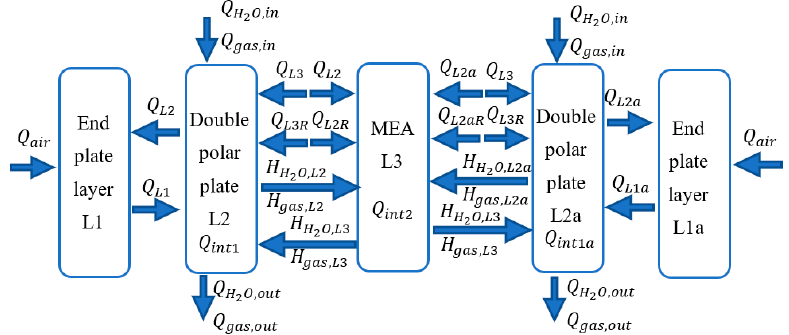
Figure 2. Diagram of fuel cell temperature model.